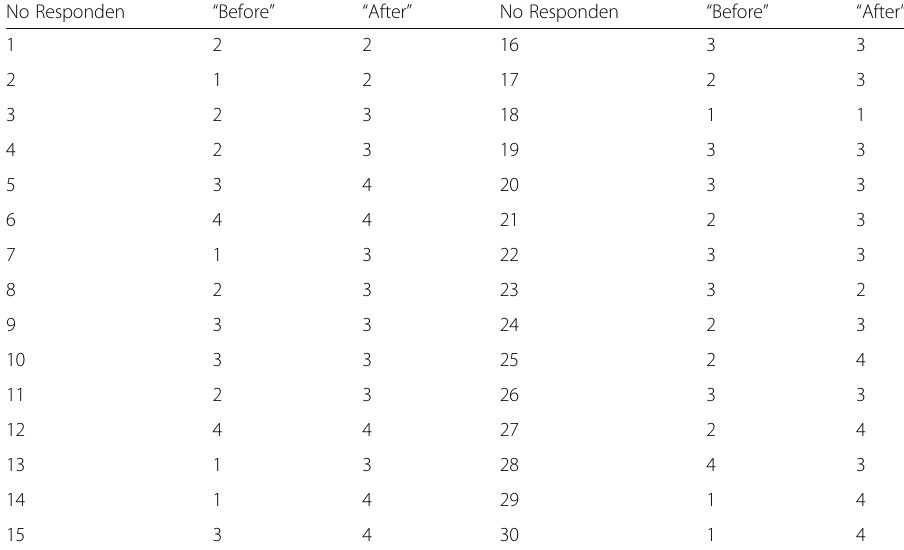
Table 3 Comparision of behavior "before" and